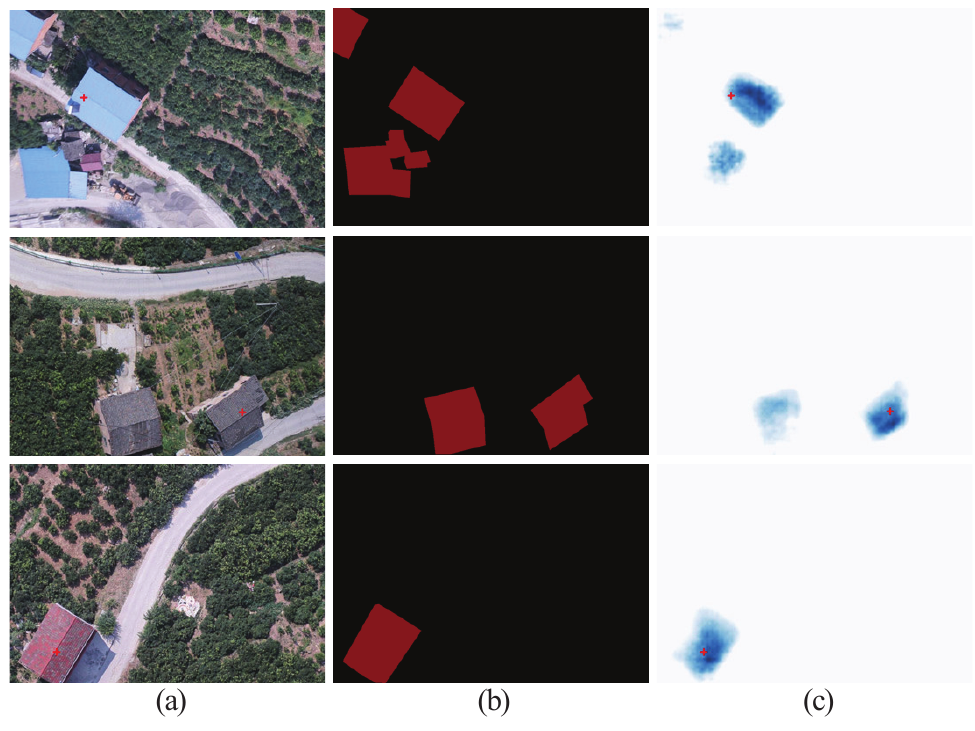
!" #" $" Figure 6. The visualization of attention maps: ( a ) images; ( b ) ground truth; and ( c ) attention maps. Note that the red crosses denote the selected pixels, and blue pixels in the attention map represent similar features.